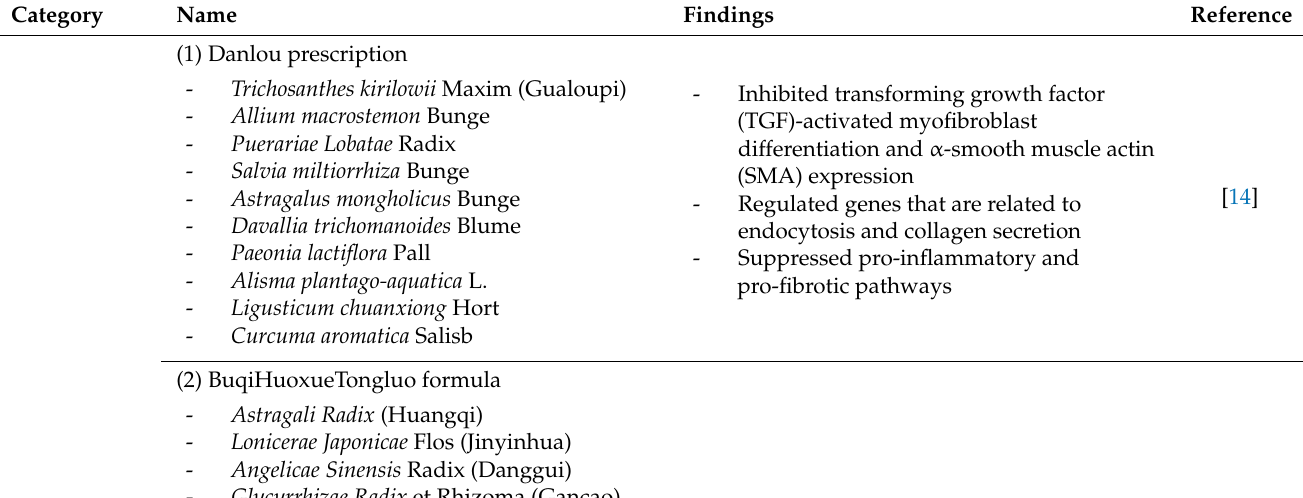
Table 1. Herbal medicines for the management of idiopathic pulmonary